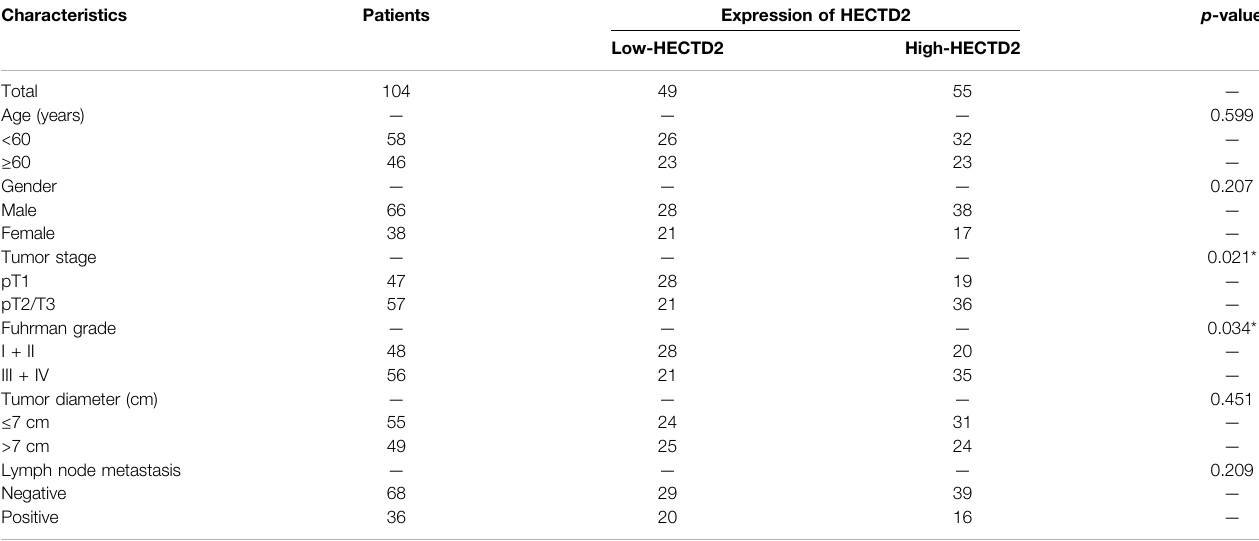
TABLE 1 | Association between the expression of HECTD2 and clinical features in tissue samples of patients with RCC. Characteristics